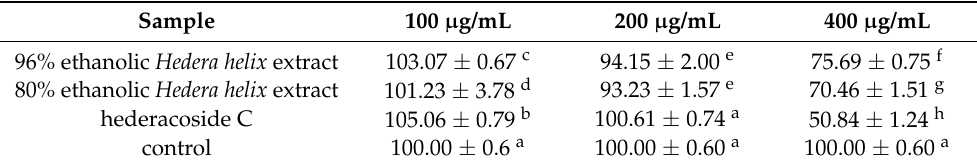
Table 1. DNA content of L929 fibroblast cells cultivated in the presence of samples. Different letters (a–h) shows the significant difference between samples (ANOVA, p <